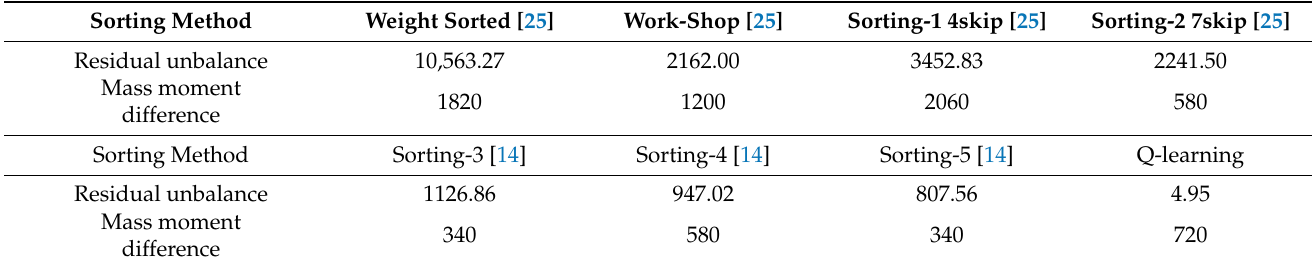
Table 2. Comparison of results of sorting methods.